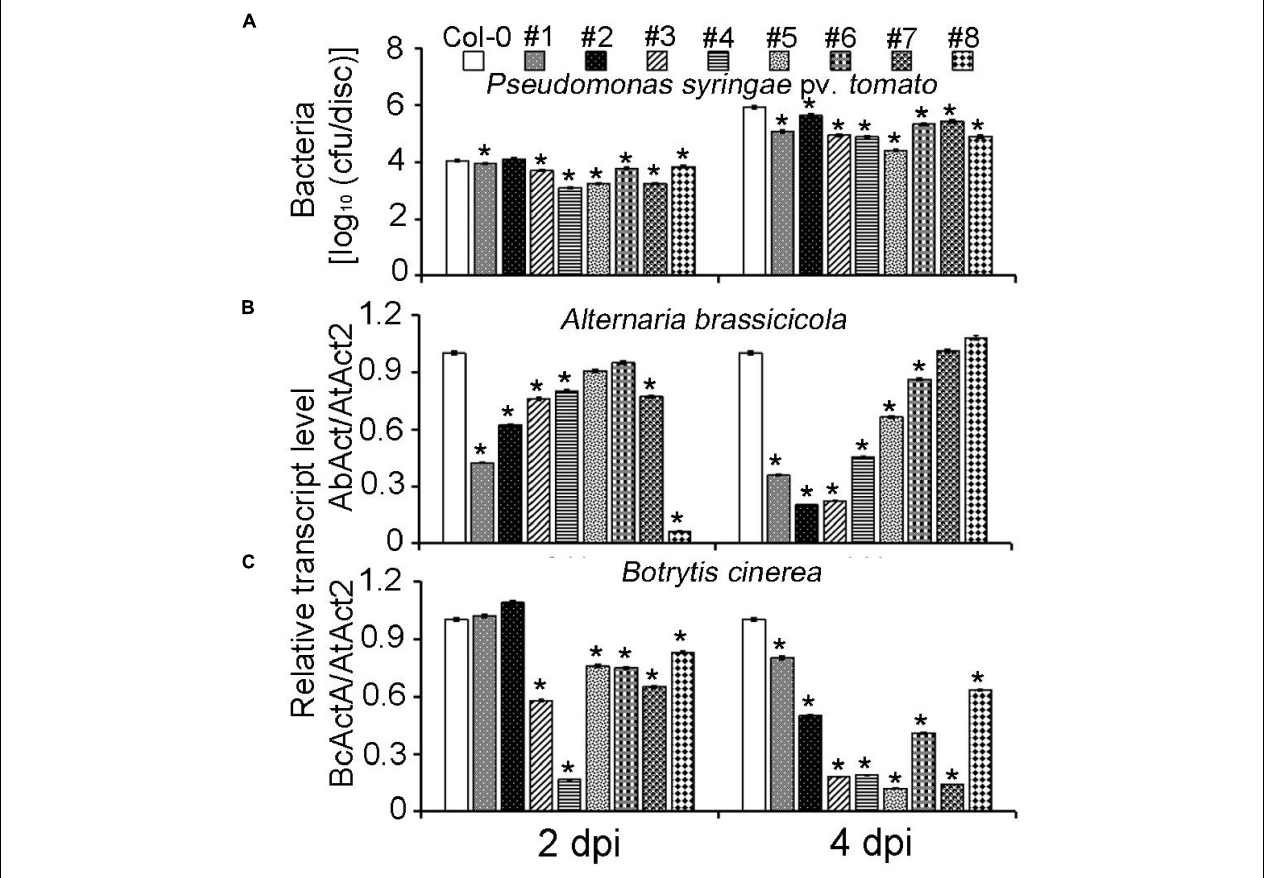
FIGURE 6 | Overexpression of MeLRRs in Arabidopsis enhances resistance to plant pathogens. (A) The number of P. syringae pv. tomato populations in overexpression Arabidopsis leaves and the wild type. The relative transcript levels of AbAct/AtAct2 (B) and BcActA/AtAct2 (C) in overexpression Arabidopsis leaves and the wild type after infection with A. brassicicola and B. cinerea , respectively. Asterisks (*) indicate significant differences at p < 0.05. Col-0 is A. thaliana ecotype Columbia-0. #1 and #2, #3 and #4, #5 and #6, and #7 and #8 are overexpression of MeLRR3 in A. thaliana Col-0 lines, respectively. dpi is days